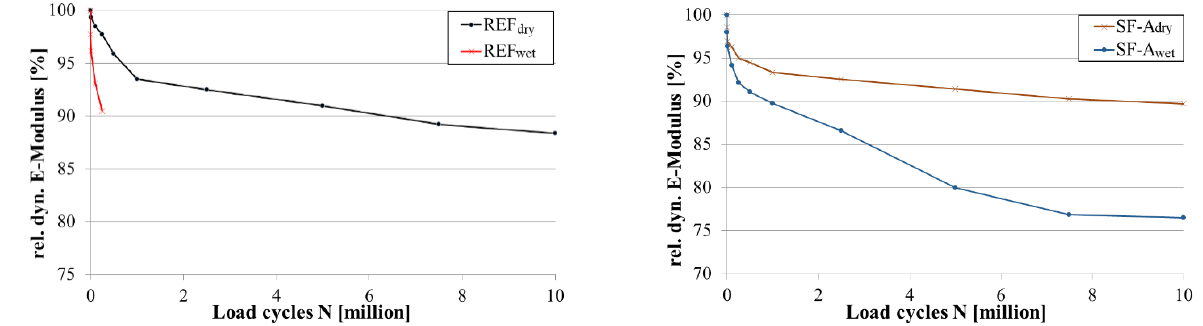
Figure 8. Decrease of the rel. dyn. E-modulus of REF (left) and SF-A (right).